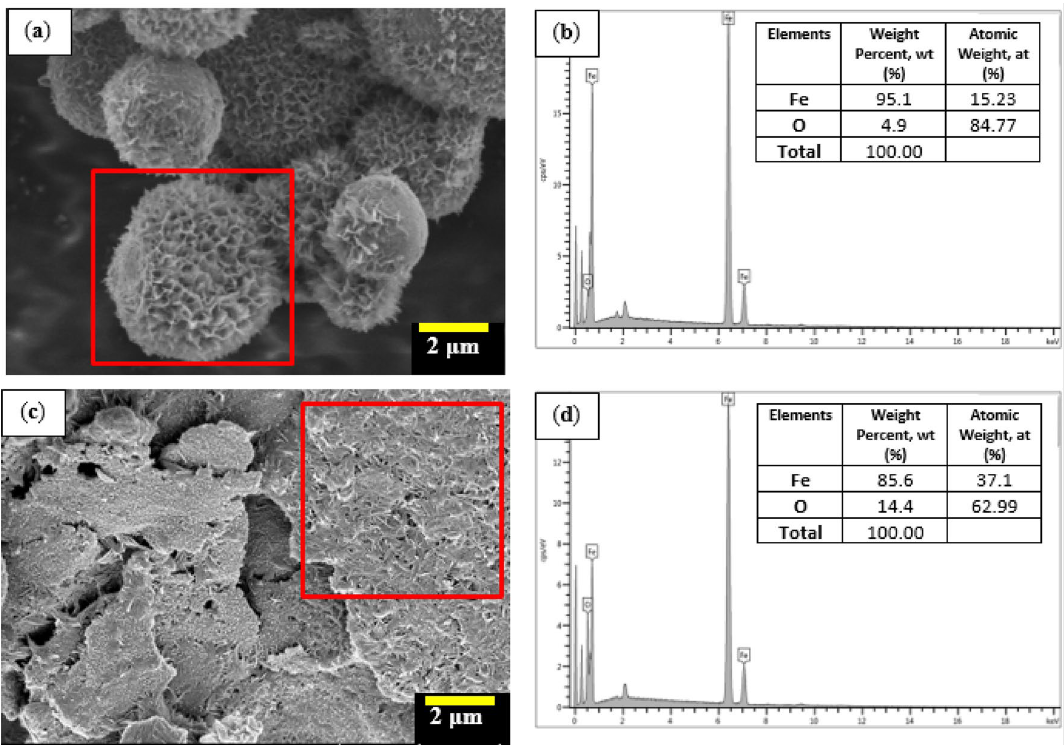
Figure 2. FESEM micrograph for ( a ) corroded spherical CIPs and ( b ) EDS analysis for corroded spherical CIPs at selected points, and ( c ) corroded plate-like CIPs and ( d ) EDS analysis for corroded plate-like CIPs at selected